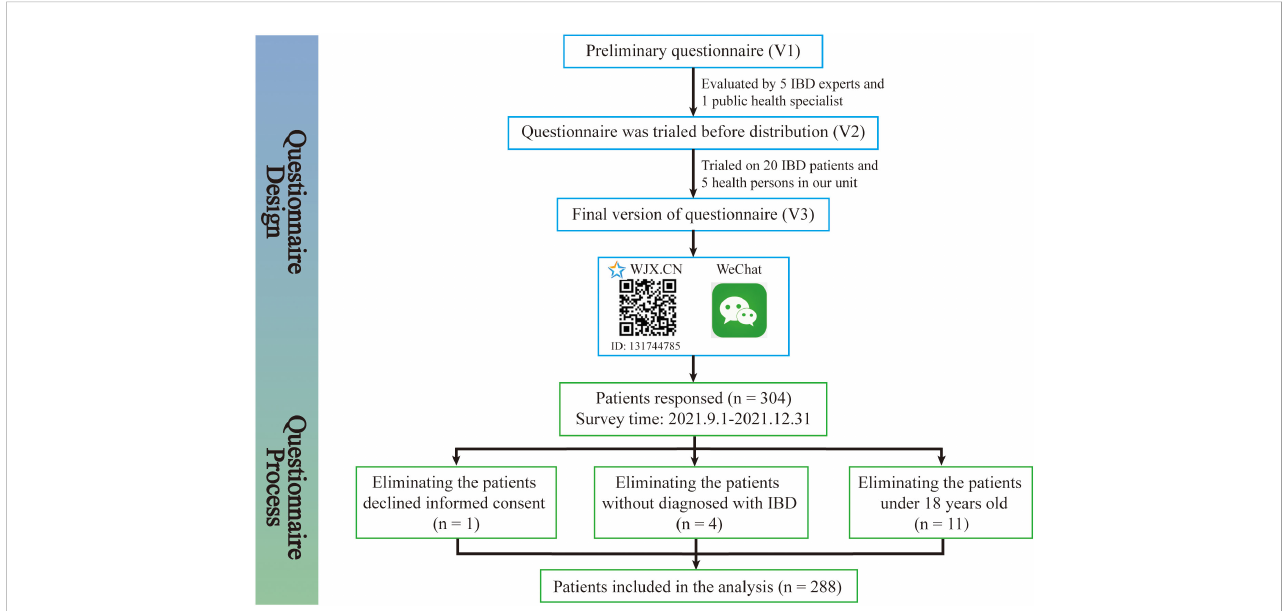
FIGURE 1 Patients enrollment fl ow chat. The patients enrollment fl ow chat was created to demonstrate the questionnaire design and questionnaire process in detail. The questionnaire was evaluated and modi fi ed by IBD experts and was produced by Wenjuanxing, which is a free and open platform for survey design. We sent the questionnaire to the WeChat group for patient management and 304 patients responded, out of which 16 respondents had to be